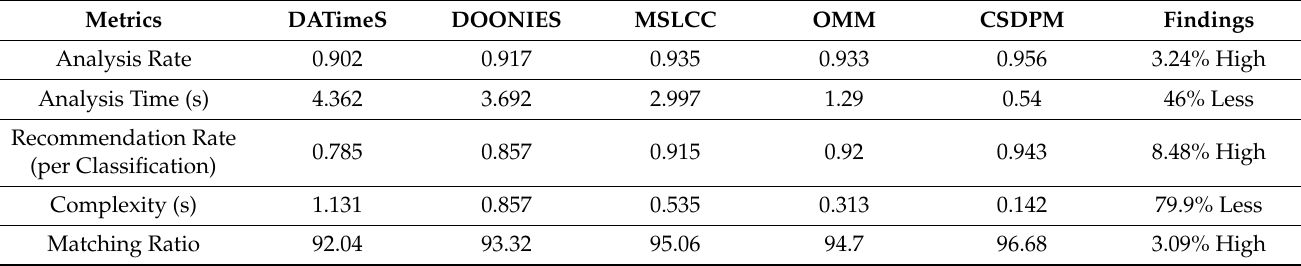
Table 1. Comparative analysis for data streams.